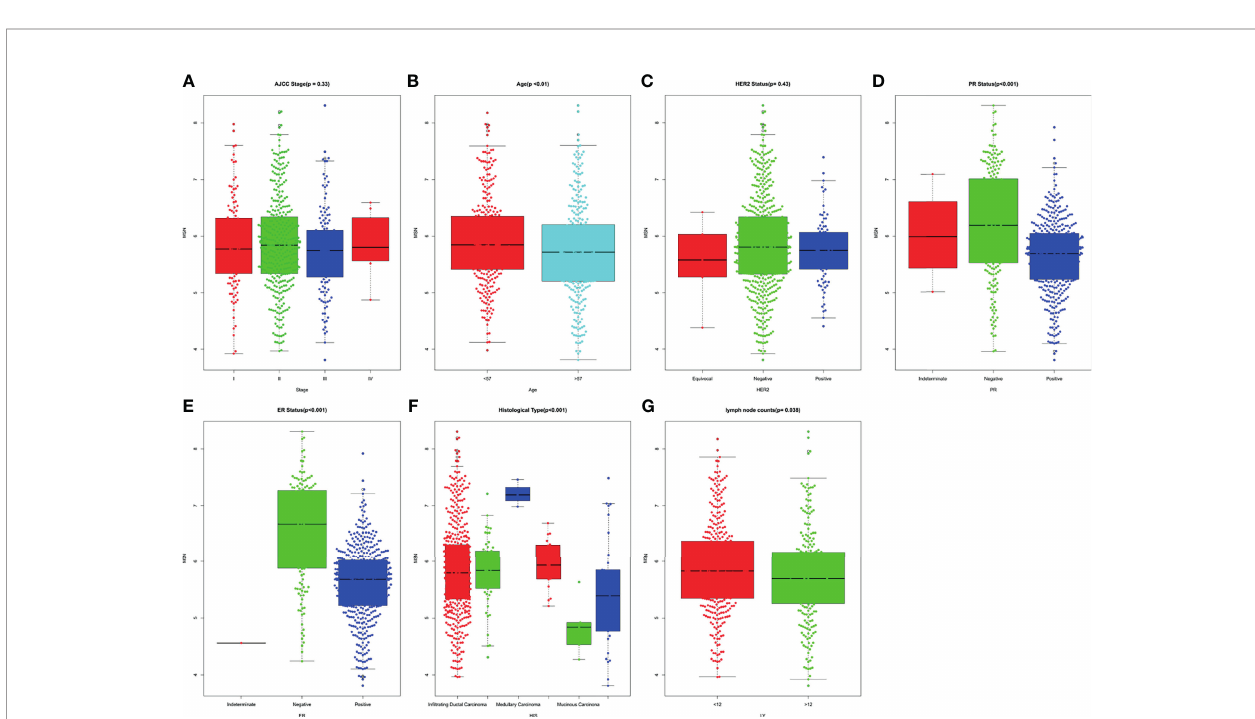
FIGURE 5 | The association of MSN expression and clinicopathological